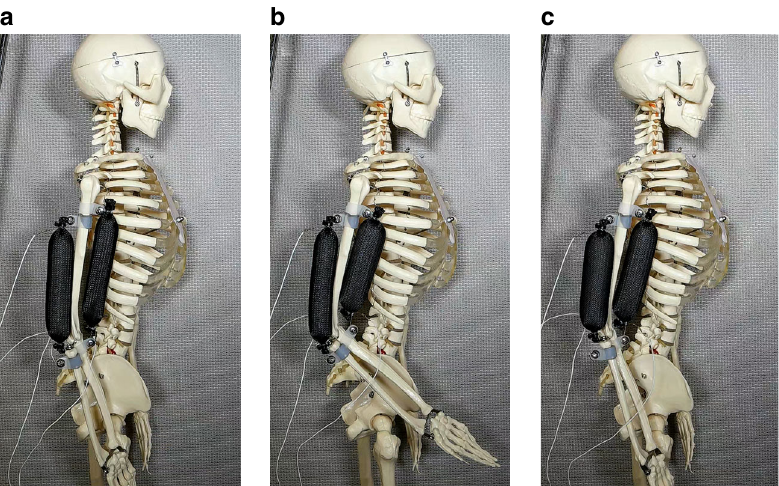
Fig. 7 Agonist-antagonist soft actuator pair (20 V, 1 A). a Initial position of biceps and triceps actuators; b Actuation (bending the arm) by biceps; c De-actuation (bringing the arm to its initial position) by triceps. Actuators size: 20 mm diameter, 100 mm length. This setup reduced actuation time by a